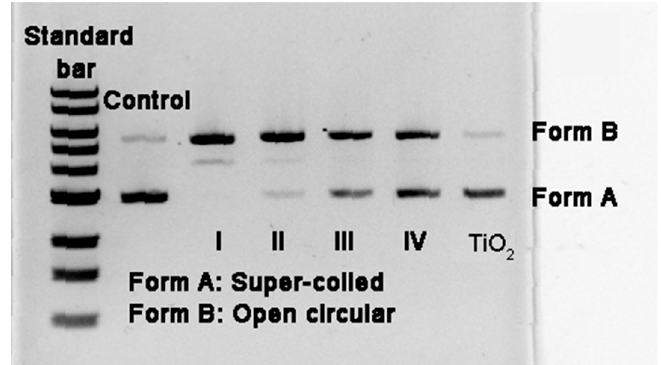
Figure 13. The cleavage of supercoiled plasmid pBR322 DNA by different samples under dark conditions for 2 h [33]. Lanes I, II, III, and IV correspond to Cu(I)/Cu(II) = 1.3, 0.2, 0.13 and Cu(II)/TiO 2 , respectively.